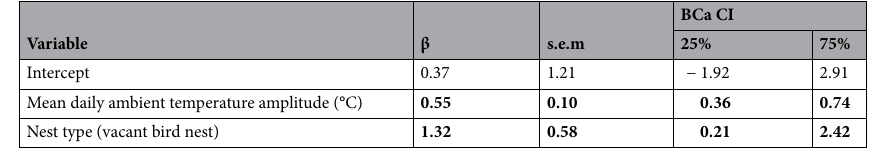
Table 3. Results of bootstrapped (2000 replications) linear regressions showing the changes of mean daily internal temperature amplitude (response variable) with main effects of the respective ambient amplitude and nest type (vacant nests of wood warblers vs. Myrmica ant nests; n = 23 each). The statistically significant results are highlighted with bold font. Bias-corrected and accelerated bootstrap confidence intervals (BCa CI) are